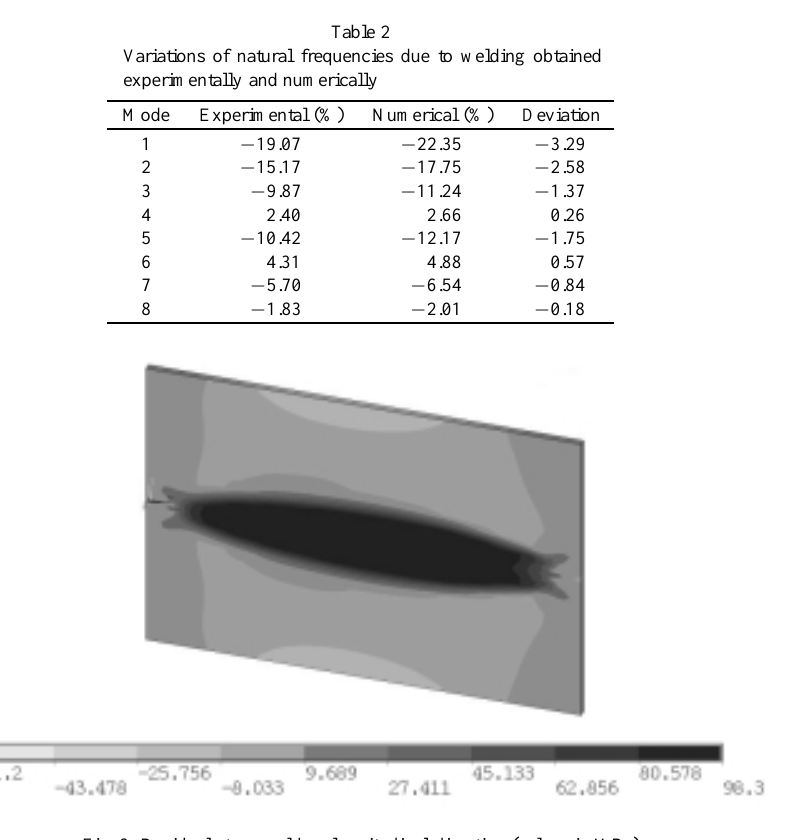
Fig. 8. Residual stress field on longitudinal direction (values in